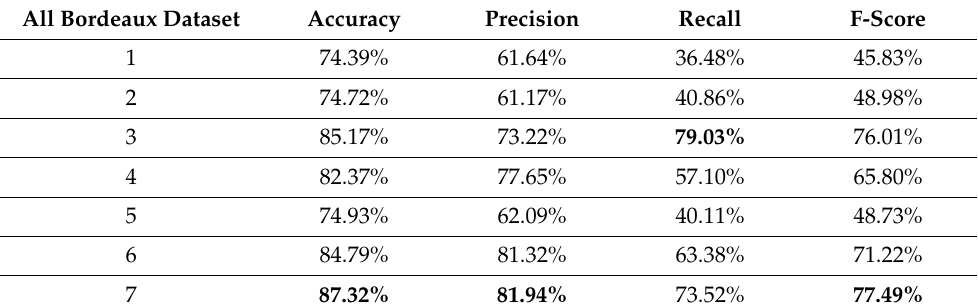
Table 3. Accuracy, precision, recall, and F-score with Naïve Bayes classifier in All-Bordeaux datasets. The highest results in each column are marked in